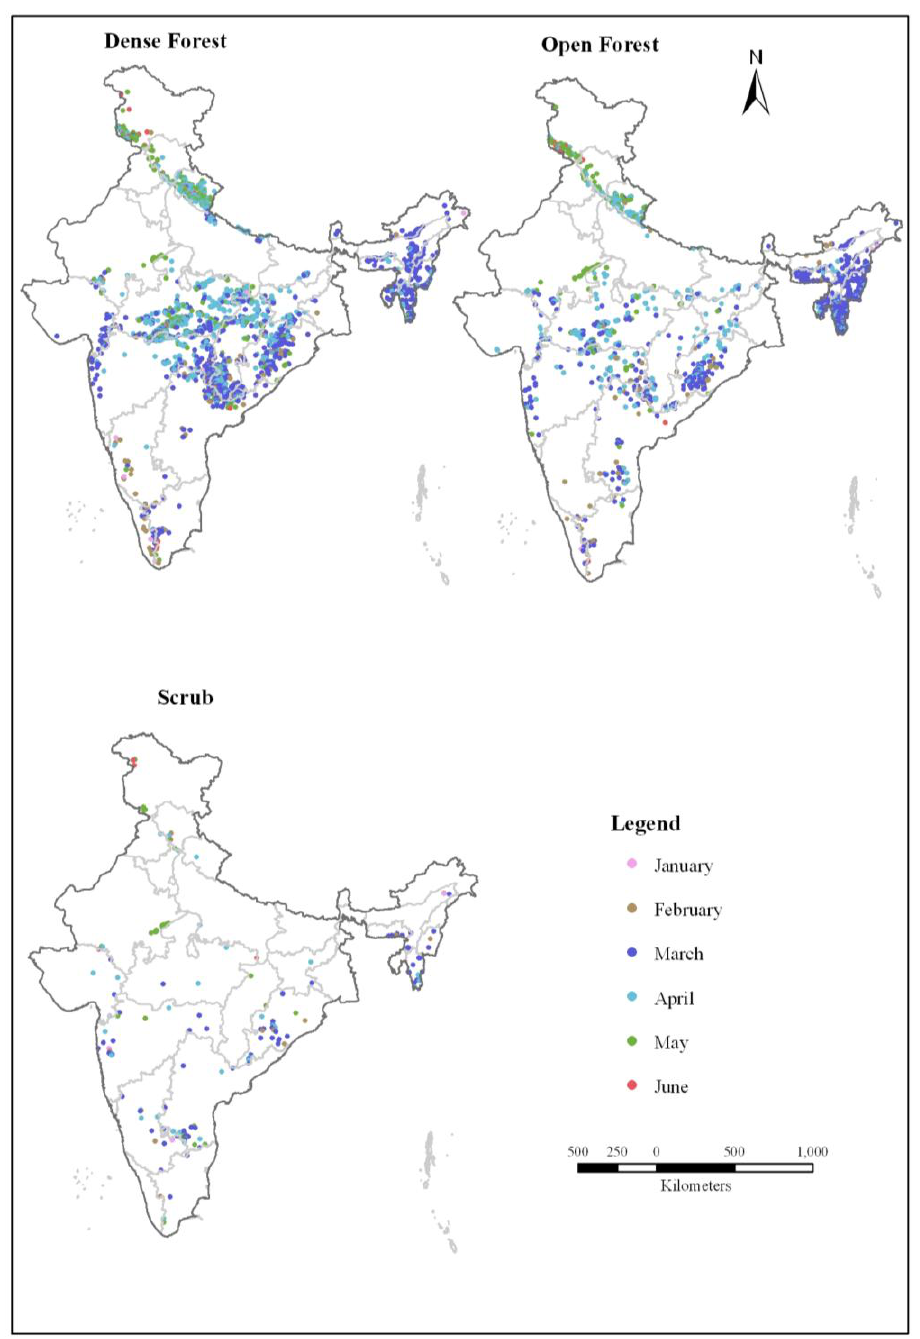
Figure 4. Map showing fire distribution in different forest density classes using A(A)TSR night-time data for the peak fire season (Jananuary–June) from 1997 to